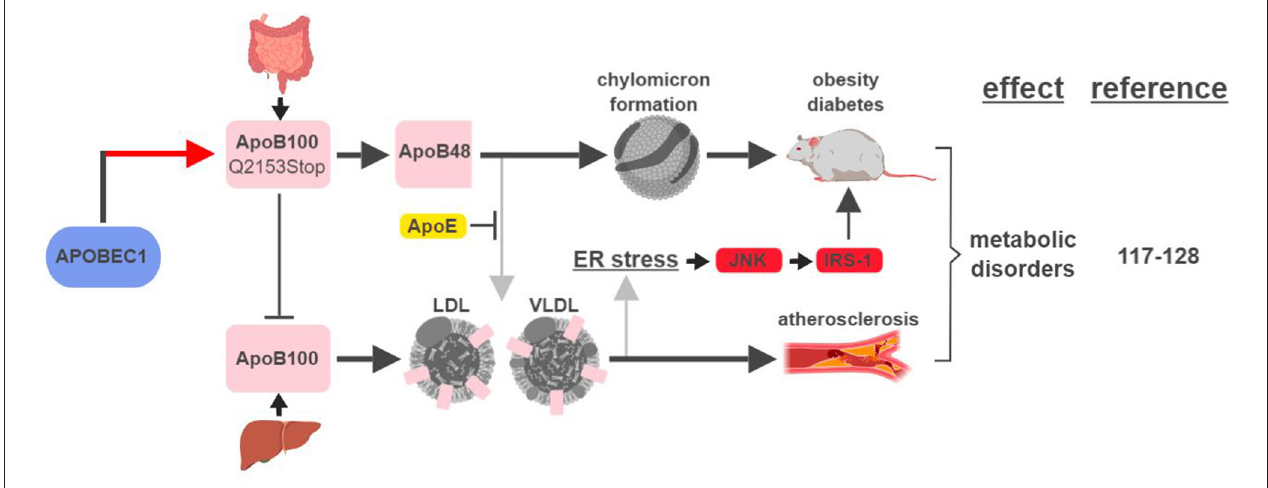
FIGURE 7 | APOBEC1-mediated RNA editing in metabolic disorders. The color of the first arrow in each pathway indicates the mechanism (refer to Figure 1 ) by which APOBEC1 regulates its direct targets, depicted in pink shapes. Additional activators of specific pathway steps are depicted in red rounded rectangles. Gray arrows point to ApoB-associated secondary functions. ER, endoplasmic reticulum; LDL, low-density lipoprotein; VLDL, very-low-density lipoprotein. The figure was created with